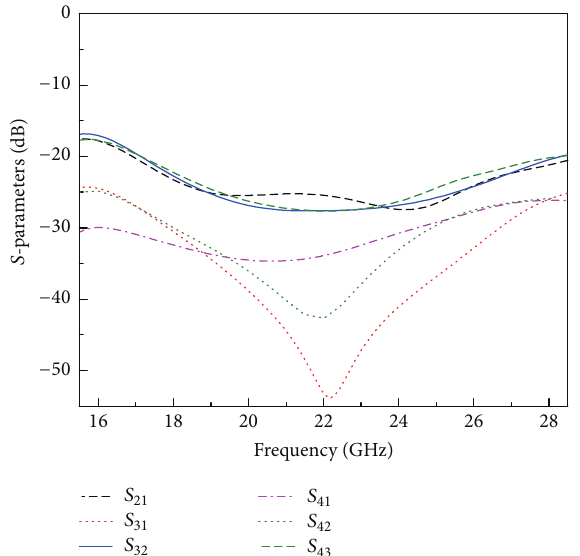
Figure 12: 𝑆 -parameters of the IMF-CBSA array without feeding